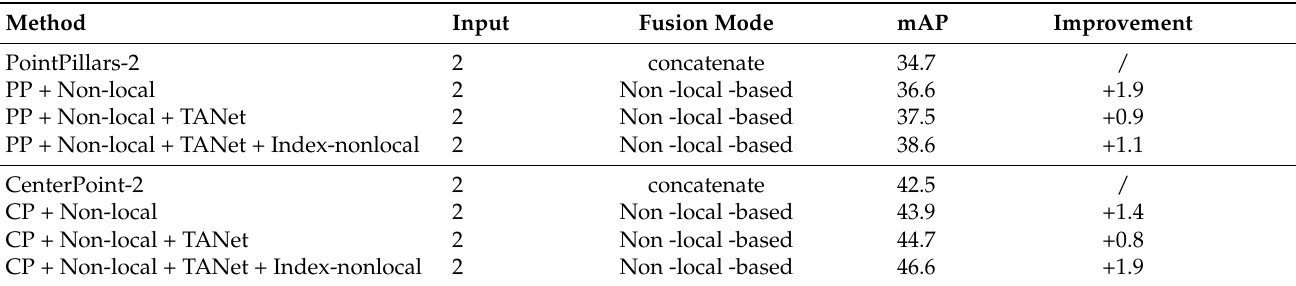
Table 5. Results of the ablation